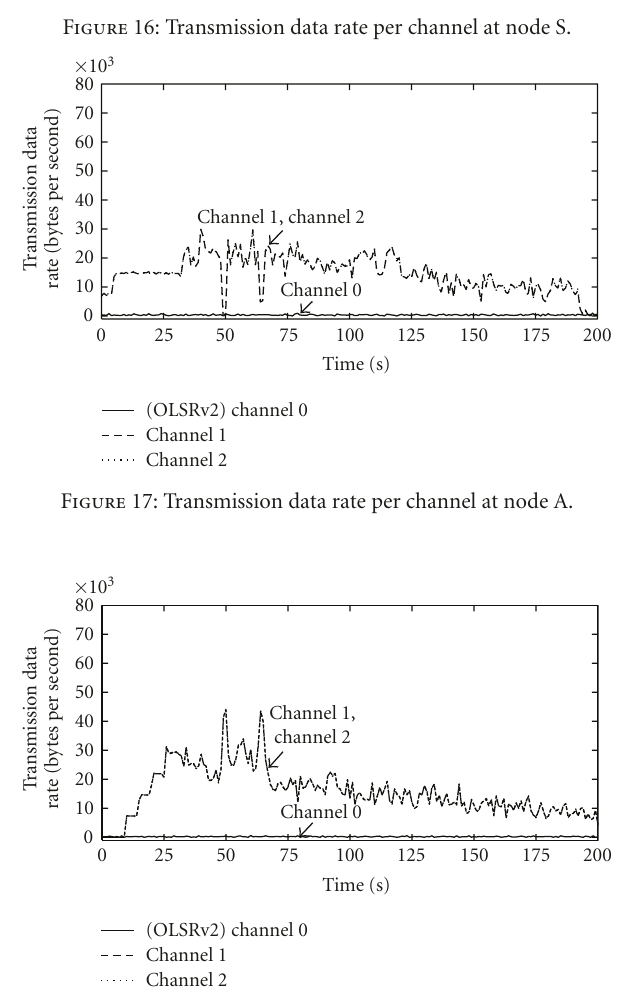
Figure 18: Transmission data rate per channel at node B.